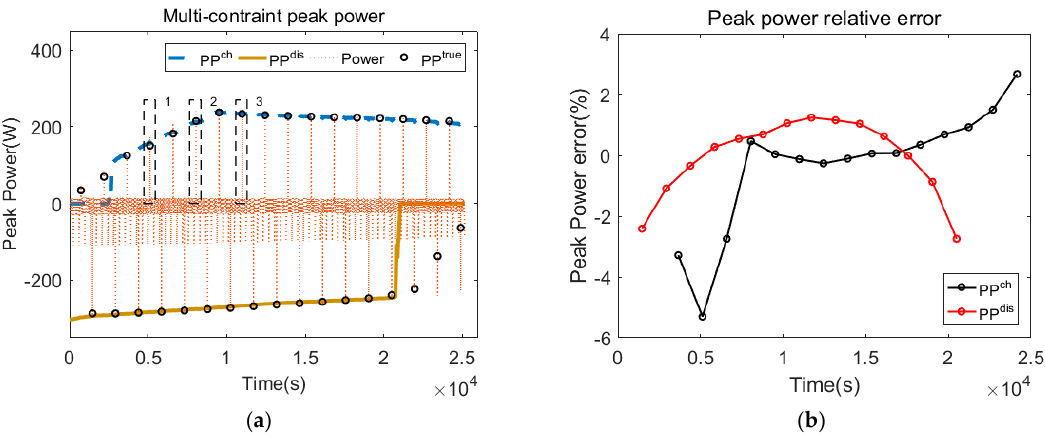
Figure 9. ( a ) Peak power under multiple constraints; ( b ) Peak power relative errors.